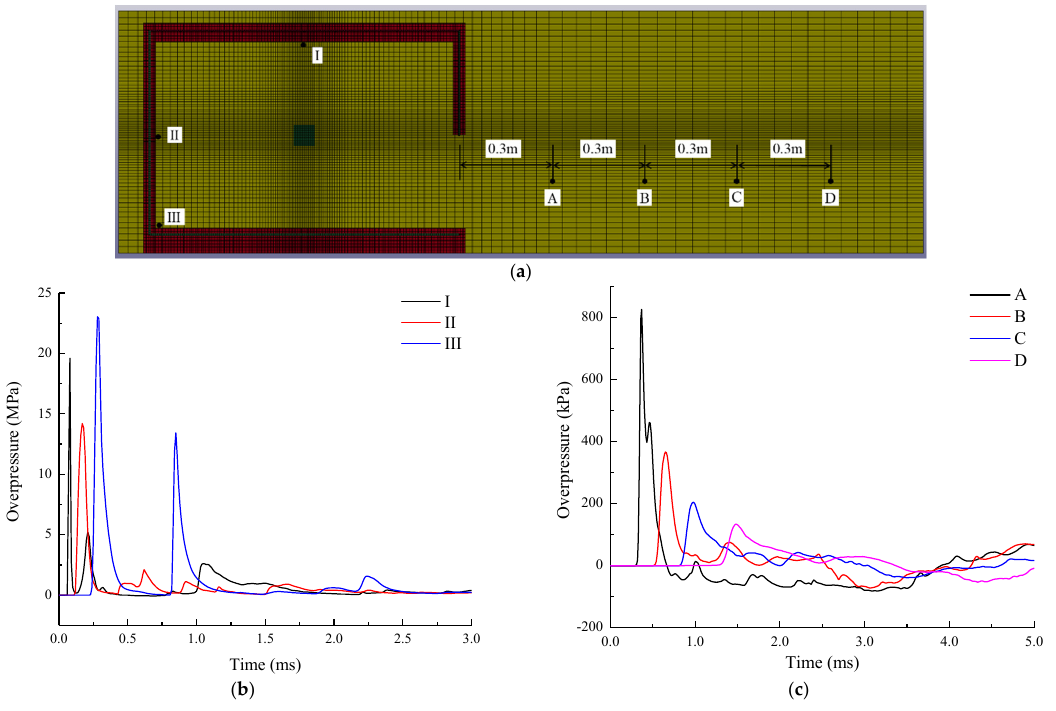
Figure 18. Pressure-time histories at different locations; ( a ) location of measuring points; ( b ) internal; ( c ) external.